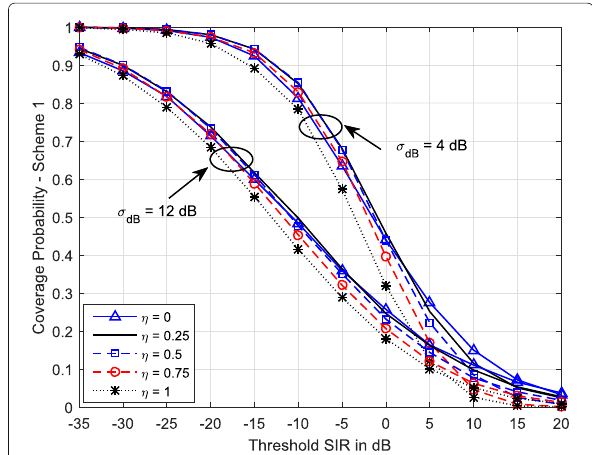
Fig. 4 Variation of coverage of Scheme 1 vs SIR threshold for different η values. λ = 0.5 BSs/km 2 , α = 3.5